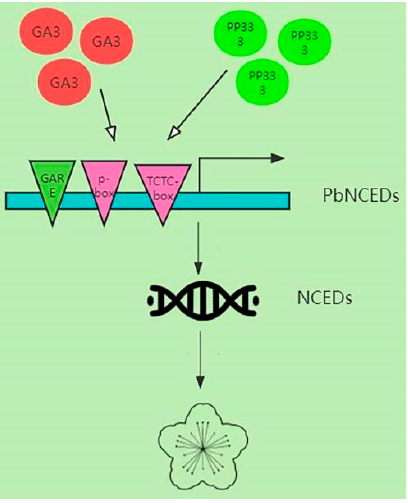
Figure 10. Patterns of calyx abscission and persistent of ‘Kuerle Xiangli’ regulated by exogenous GA 3 and PP 333 .